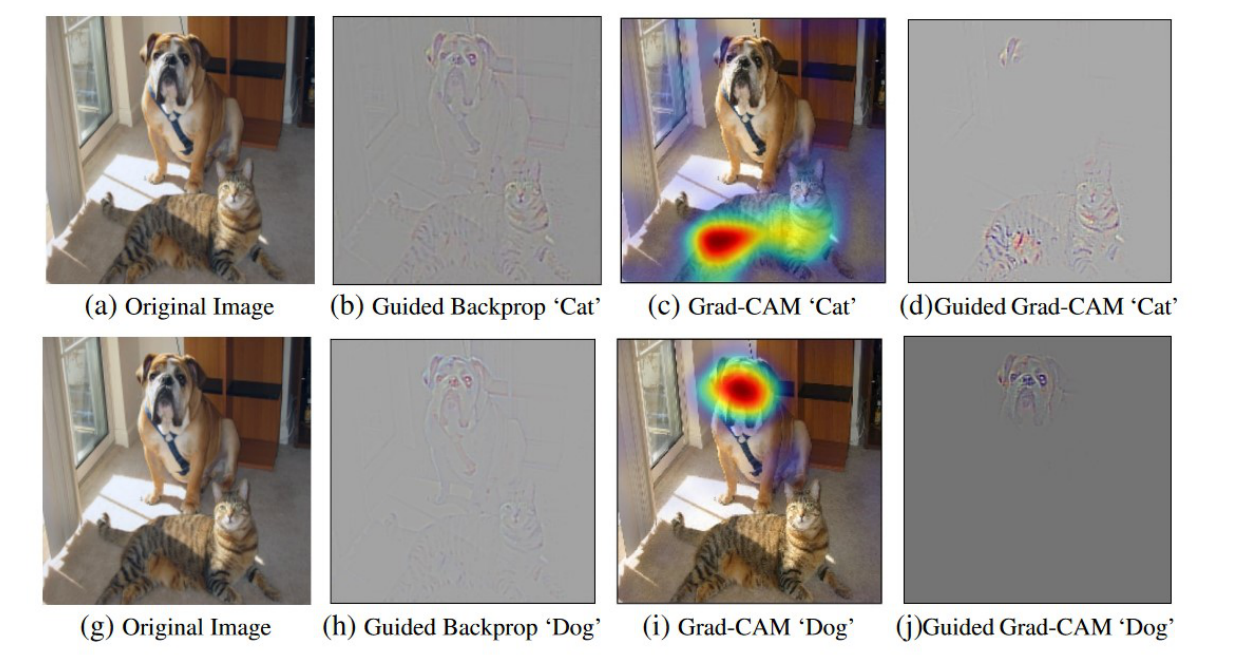
Figure 3. (a) and (g) are original image with cat and dog. (b) and (h) illustrate Guided Backpropagation of cat and dog respectively. The Grad-CAM are visualized in (c) and (i), whereas the combination of Grad-CAM and (b), (c) are presented in (d) and (j)